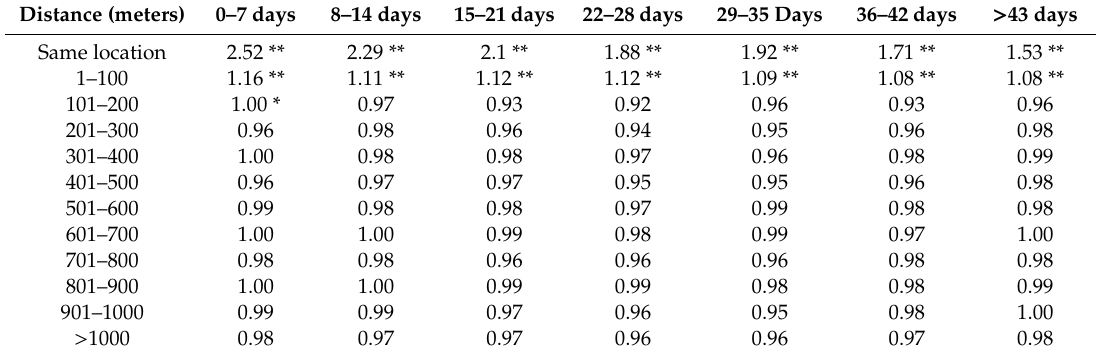
Table 4. Risk of VMVT after